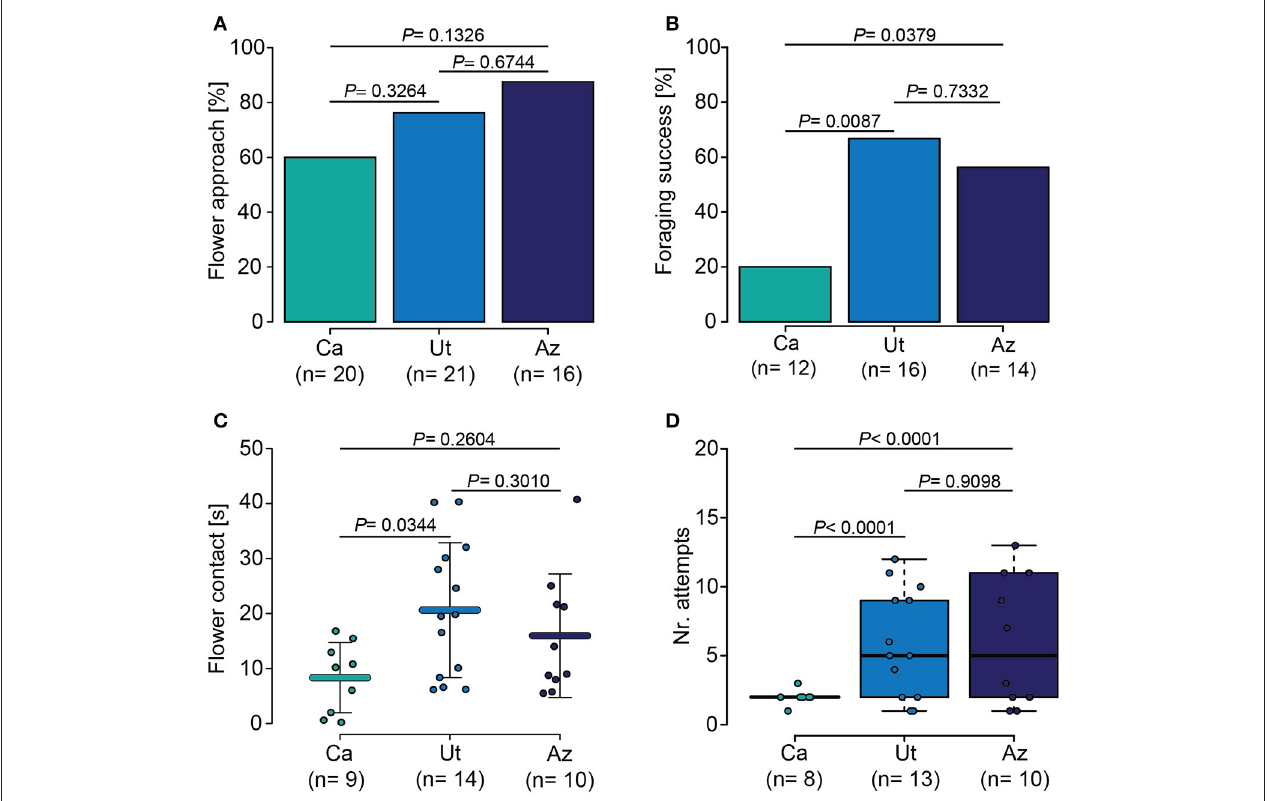
FIGURE 2 | Behavioral response of M. sexta to different N. attenuata populations. (A) Moths initially approached plants of all three populations equally. (B) Moths were significantly more successful when foraging on flowers from the Utah (Ut) and Arizona (Az) populations compared to the California (Ca) population. (C) Moths invested significantly more time into handling flowers from the Ut population than into handling Ca flowers. (D) Moths visited and re-visited flowers of the Ut and Az populations significantly more often than flowers of the Ca population. Error bars in (C) represent the standard deviation. Error bars of the boxplot in (D) indicate 1.5 times the interquartile range; boxes depict 1st and 3rd quartiles. Dots in all graphs show individual measurements. Holm-corrected Fisher’s Exact test in case of parametric data in (A,B) , ANOVA and GLM followed by a Holm- corrected LSD for parametric data in (C) and non-parametric data in (D) ,